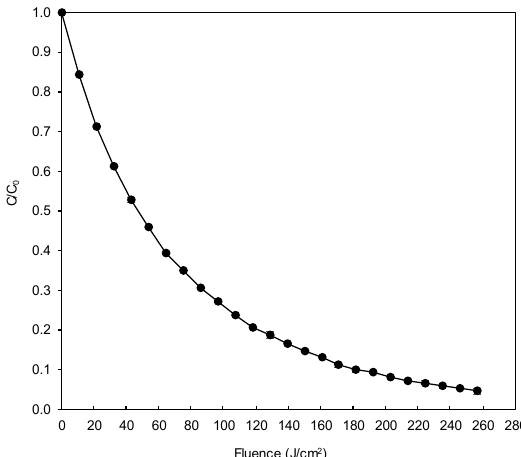
Figure 9. Degradation of DB78 by the H 2 O 2 / pulsed light advanced oxidation process in model wastewater.